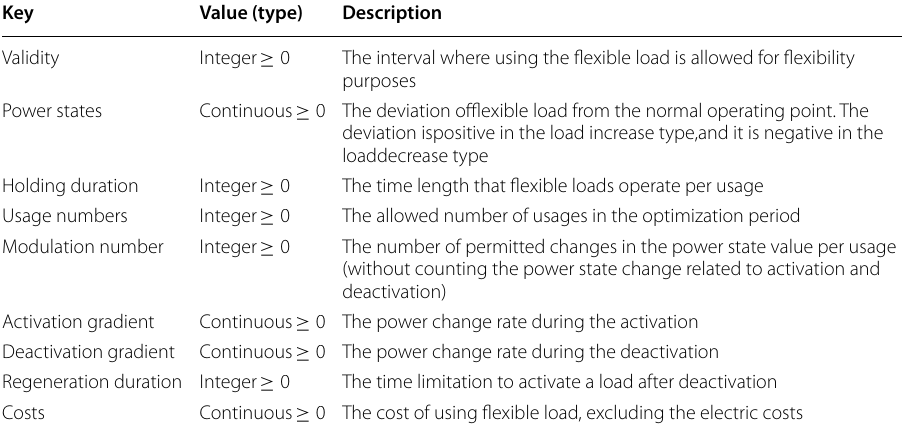
Table 1 Key figures of the EFDM as used by the optimization model Key Value (type)